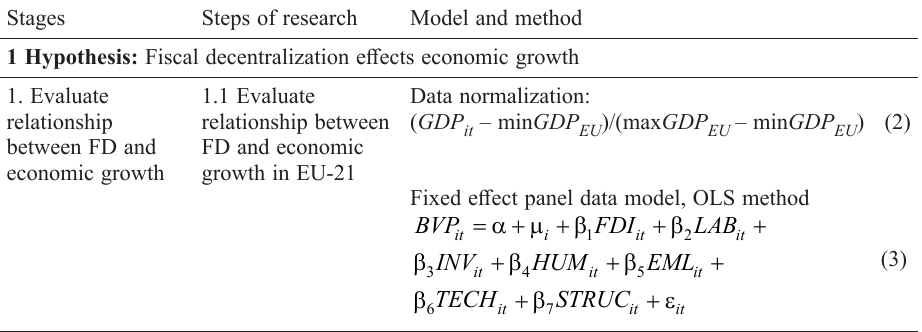
Table 3. Evaluation steps of FD effects on economic